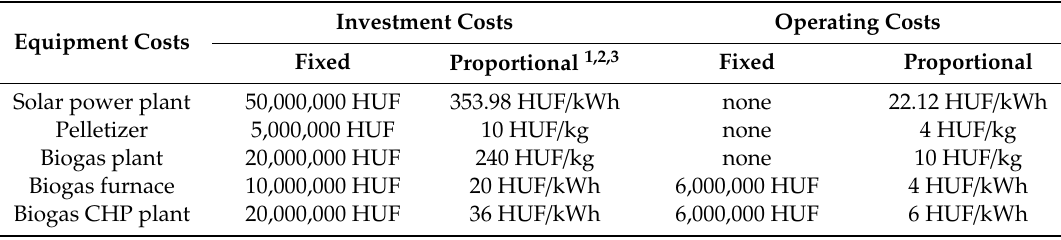
Table 5. Possible investments. These are all new equipment units in the case study, also called operating units.